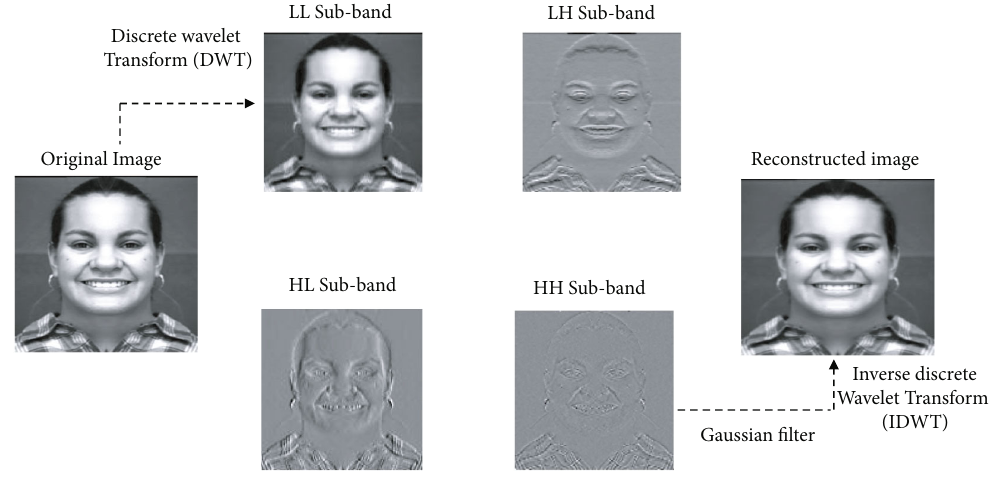
Figure 6: DWT preprocessing